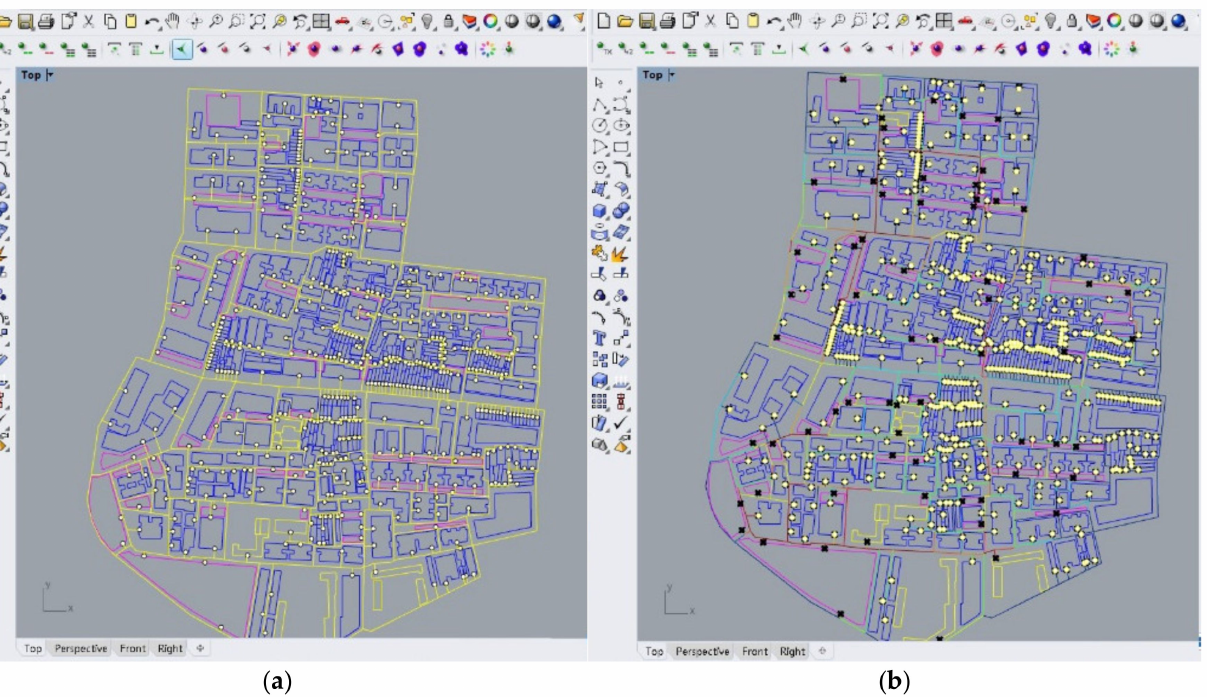
Figure 6. ( a ) UNA network model diagram of residents’ walking route (yellow line indicates the path), ( b ) UNA network model diagram of residents’ walking starting points (yellow dot indicates the starting